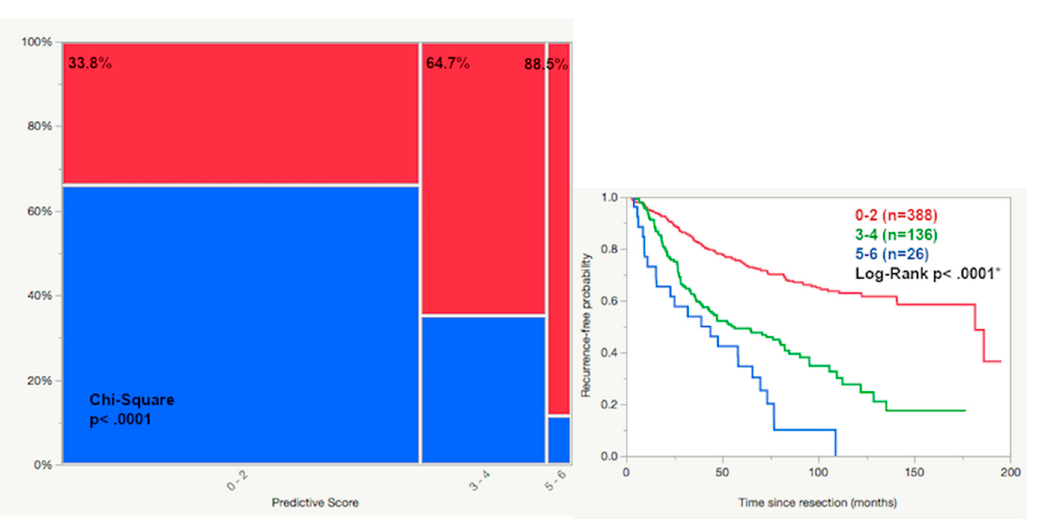
Figure 4. The predictive score consists of the sum of the following factors: male gender (1), CNS invasion detected by histopathology or intraoperative assessment (1), WHO grade II or III (2) and Simpson grade >3 (2). Scoring groups of 0–2, 3–4 and 5–6 were generated and showed a significant difference in tumor recurrence of 33.8, 64.7 and 88.5%, respectively (recurrence red, non-recurrence blue, 5-year follow-up or longer, asterisk (*): statistically significant result).